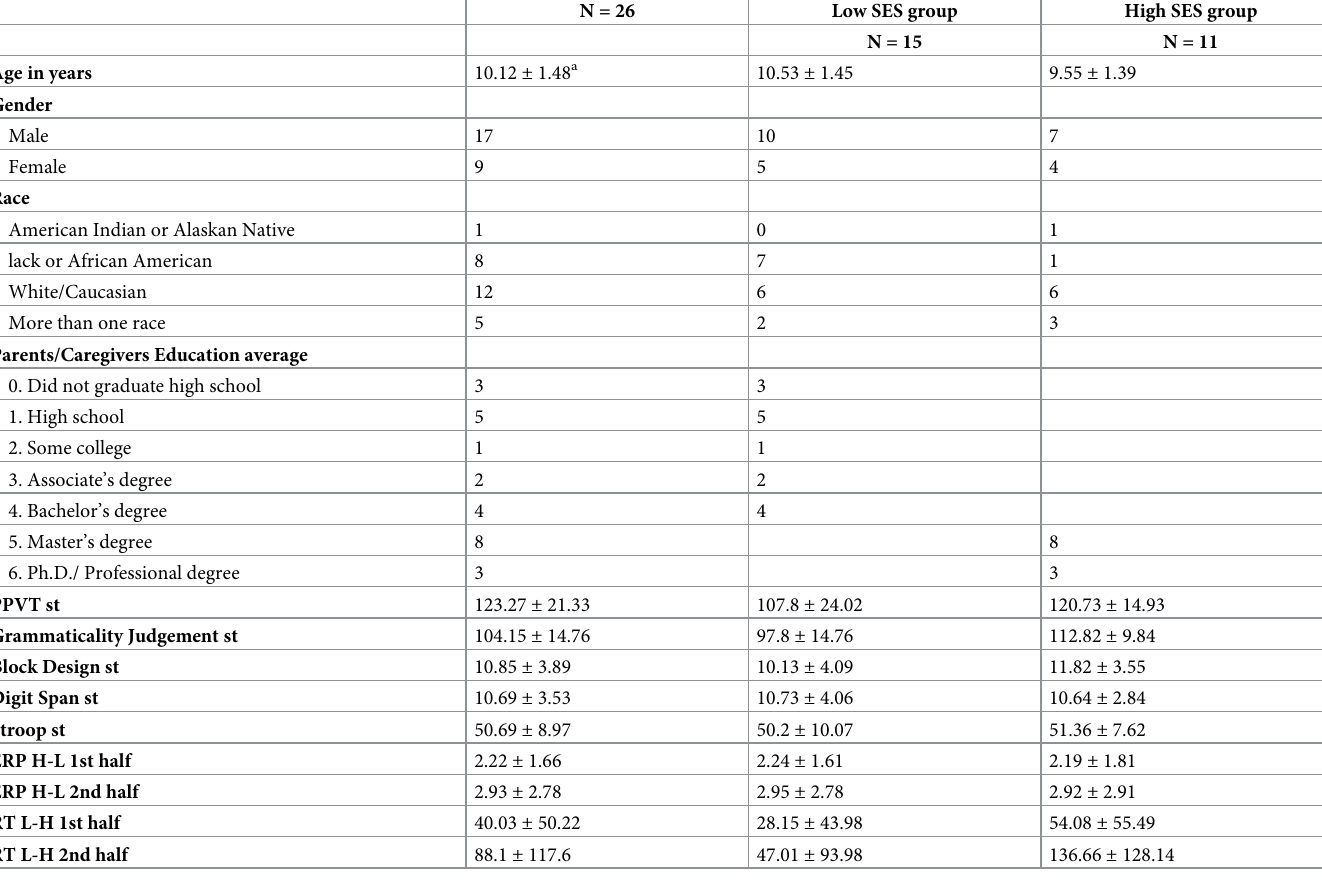
Table 1. Participant characteristics and descriptive